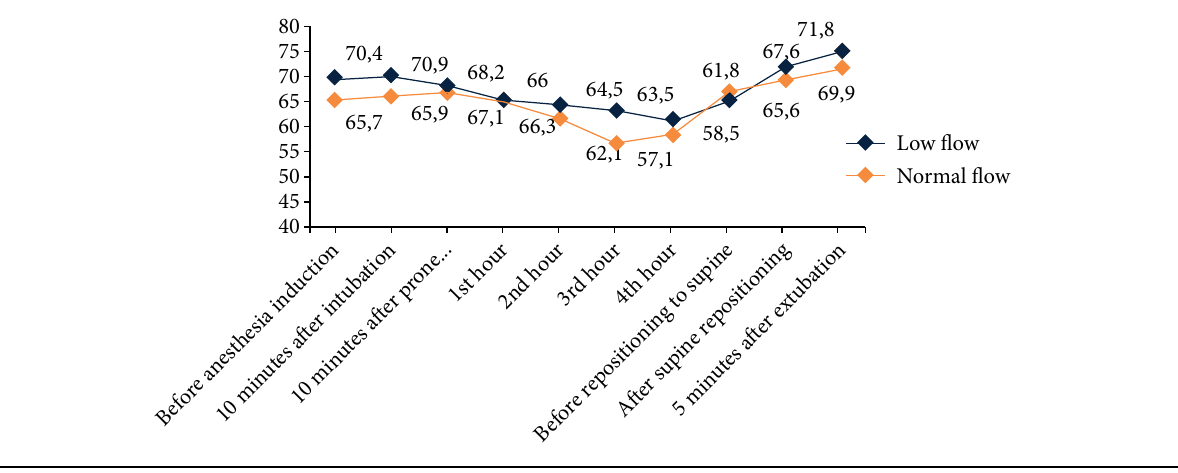
Figure 3 – Right-sided cerebral oxygen saturation measurements during study